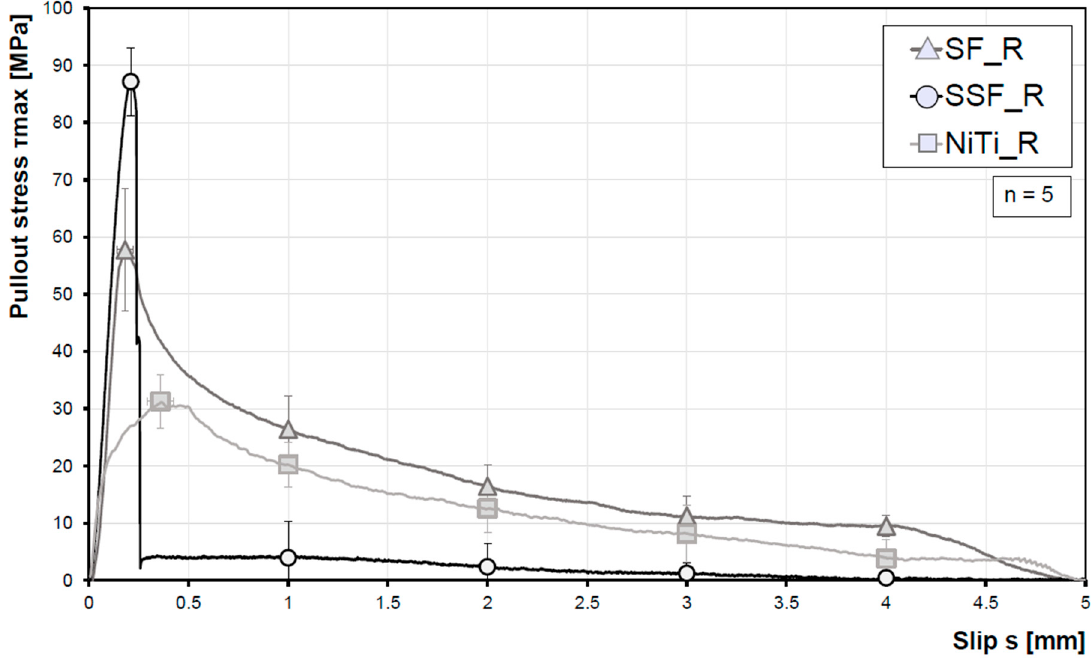
Figure 7. Average fibre pullout stress versus slip curves for the different fibre types. Table 3. Results of the fibre pullout tests for the different fibre types following laser surface treatment.